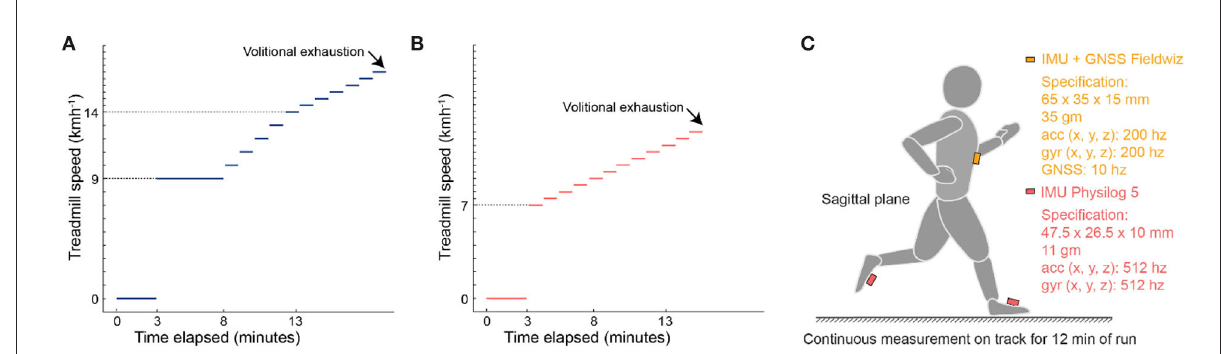
FIGURE1 Protocol and sensor setup. (A) Incremental speed protocol till volitional exhaustion for highly experienced runners. (B) Incremental speed protocol till volitional exhaustion for amateur runners. (C) Sensor configuration for field measurement. IMU, inertial measurement unit; GNSS, global navigation satellite system; acc, accelerometer; gyr,